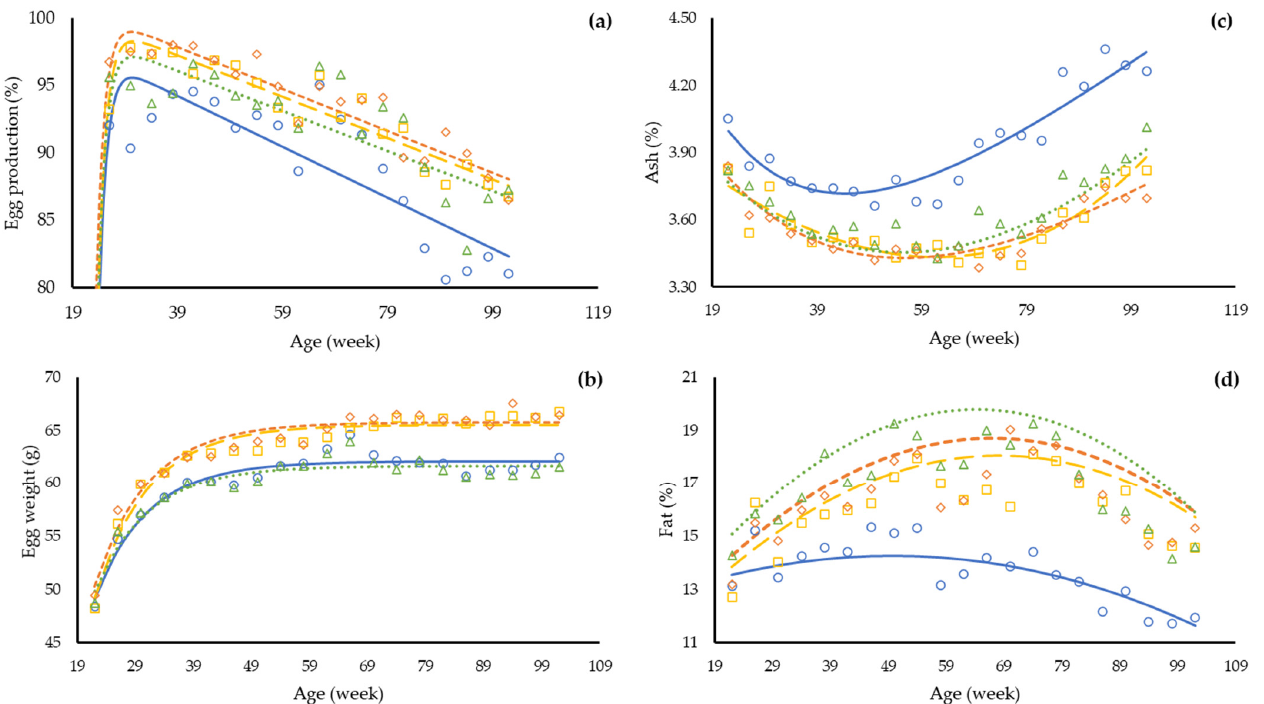
Figure 1. Observed and predicted egg production ( a ), egg weight ( b ), body ash ( c ), and body fat ( d ) of laying hens from 19 to 102 weeks old in response to four diet programs with distinct levels of dietary balanced protein feeds. Treatments: LL ( ○ , — ) and HH ( ◊ , - - ), reduction and accretion in using balanced protein (BP) during rearing period and laying period; LH ( □ , – – ) and HL ( ∆ , ∙∙∙ ), repletion and depletion in BP in laying period.